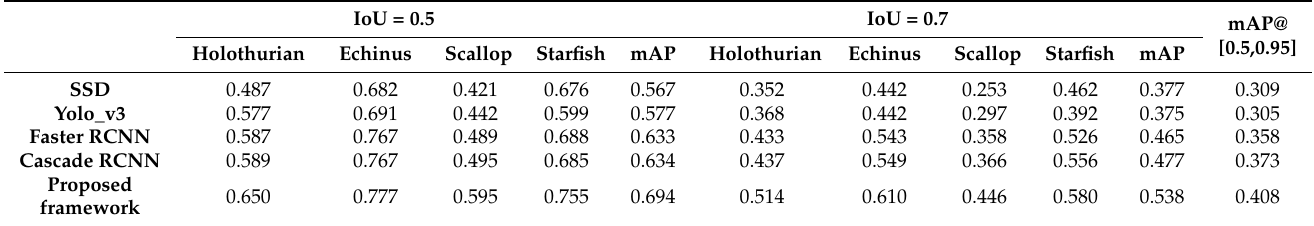
Table 4. Detection precision of different models for various underwater targets with IoU thresholds of 0.5 and 0.7.